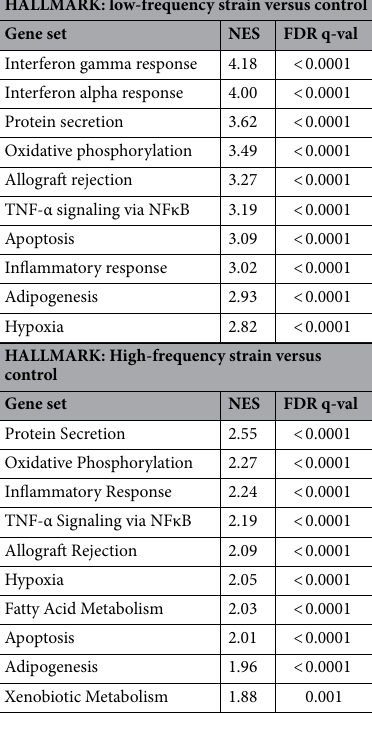
Table 2. Top 10 Enriched Hallmark gene sets for low and high frequency tensile strain. FDR, false discovery rate; NES, normalized enrichment score.